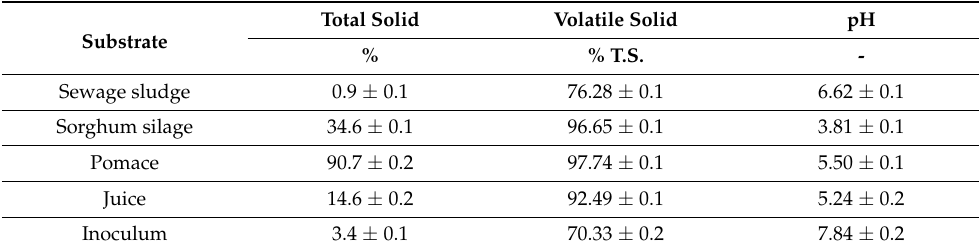
Table 1. Characteristics of sewage sludge and